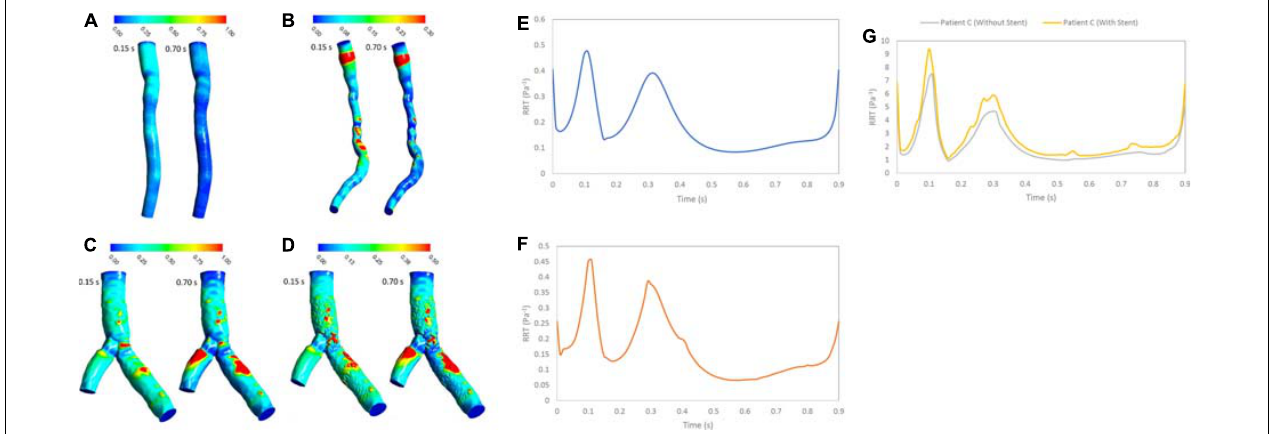
FIGURE 8 | RRT (Pa - 1 ) (A) for patient A, (B) for patient B, (C) for patient C without stent, and (D) with stent during both systole (0.15 s of pulse) and diastole (0.7 s of pulse) RRT (Pa - 1 ) on the wall (E) for patient A, (F) for patient B, and (G) for patient C in a cardiac